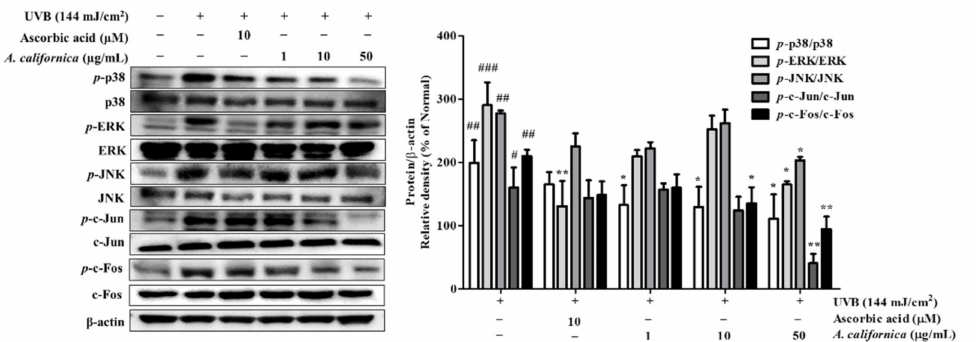
Figure 7. Effect of A. californica extract on the protein expression of phosphorylated MAPK/AP- 1in UVB-irradiated HDF cells. Data are presented as the mean ± SD. # and * indicate significant differences from the non-irradiated control and UVB-treated groups, respectively. #, ##, and ### p < 0.05, 0.01 and 0.001 vs. the non-treated group, respectively. * and ** p < 0.05 and 0.01 vs. the UVB-treated control,